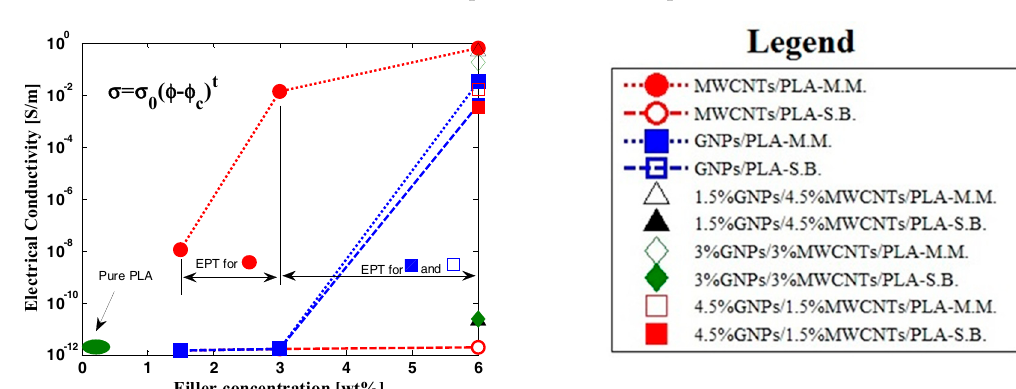
Figure 5. Conductivity of nanocomposite systems as a function of the fillers concentrations (wt %).